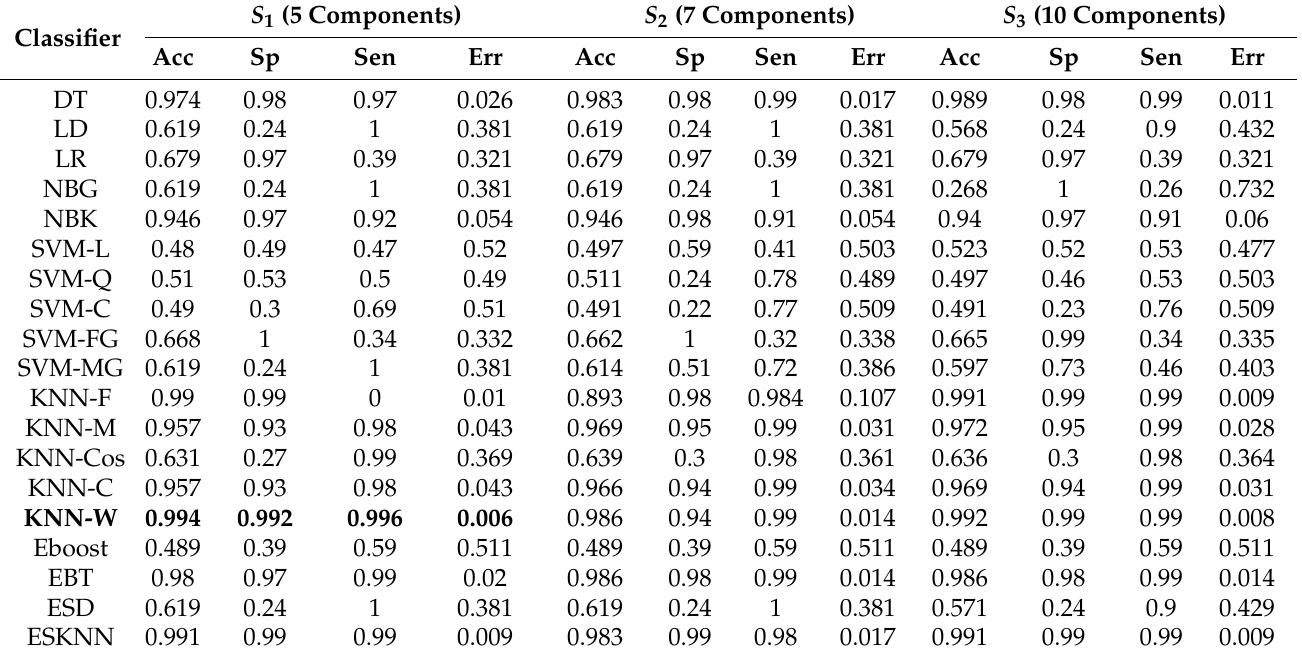
Table 12. Feature analysis table ( S 1 , S 2 , S 3 ) for method II. Bold font indicates the best results.